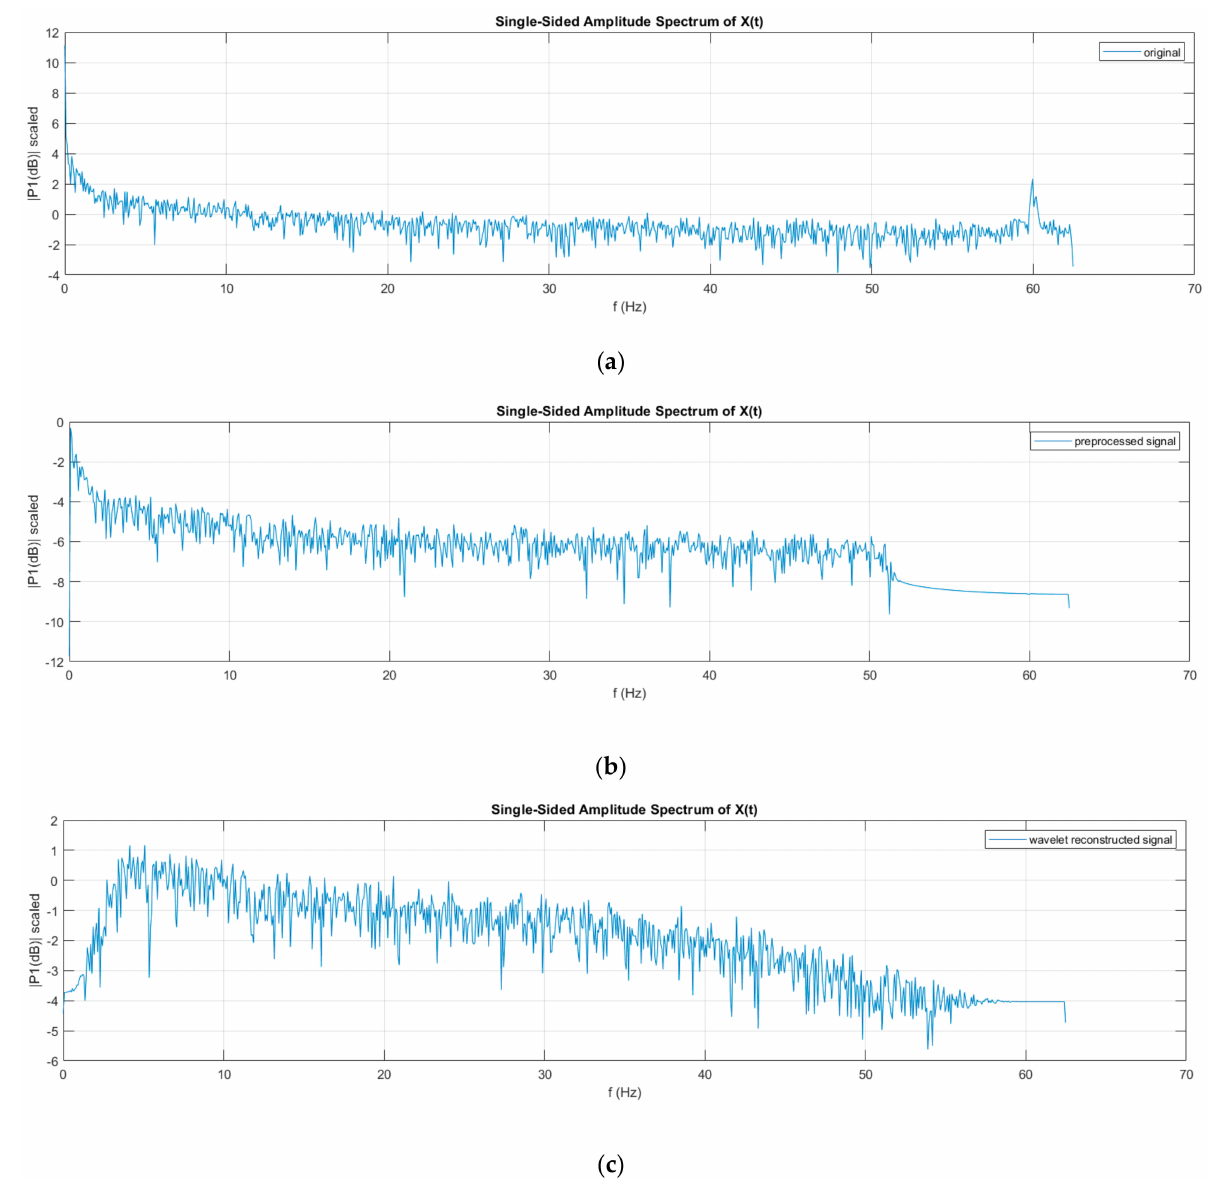
Figure 17. Fourier transform comparison of channel 16 ( a ) before; ( b ) after pre-processing; and ( c ) after wavelet